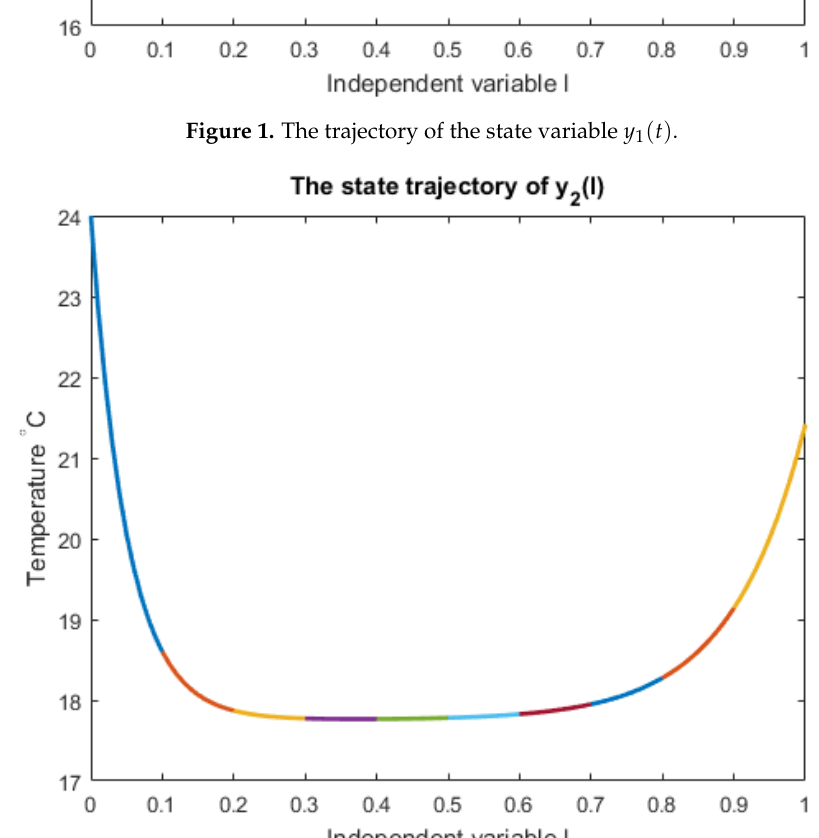
Figure 2. The trajectory of the state variable y 2 ( t )